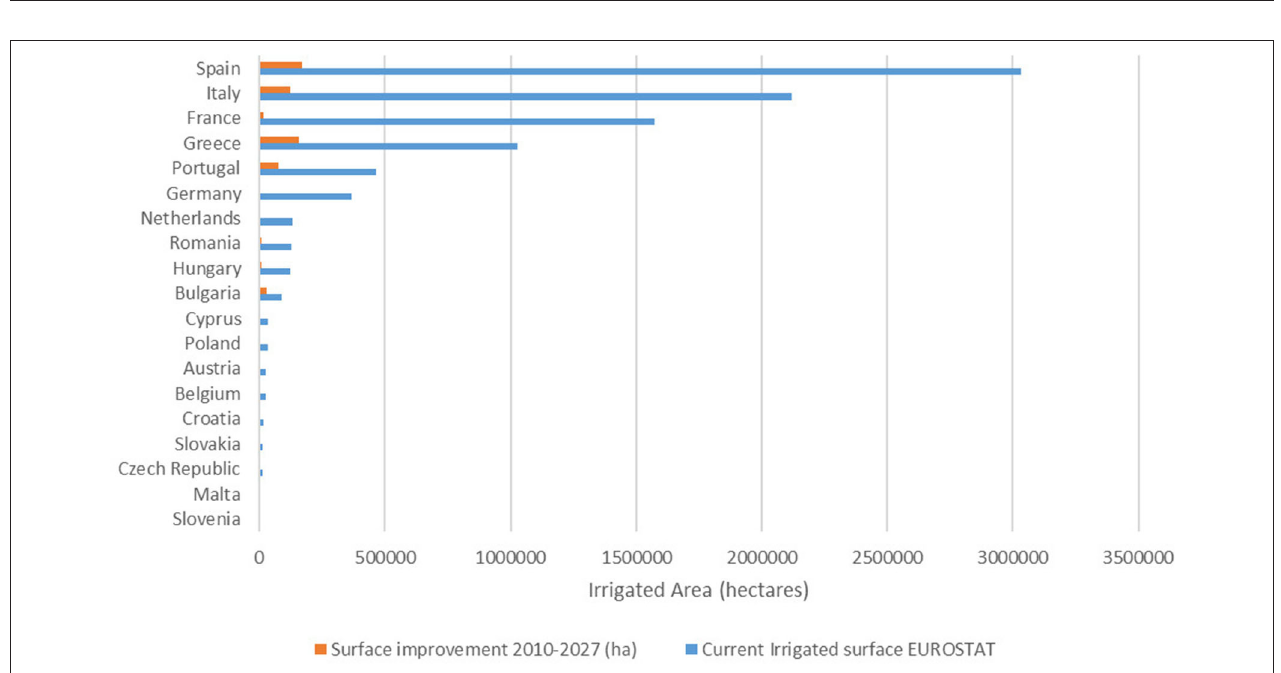
FIGURE 6 | Planned investments in irrigation to improve water efficiency (source data from Benitez Sanz et al., 2018).